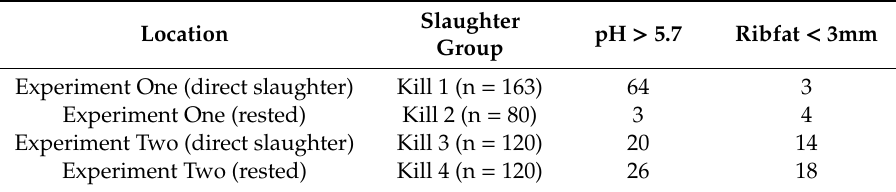
Table 4. Summary of MSA non-compliance for pHu and rib fat by location and kill. Location